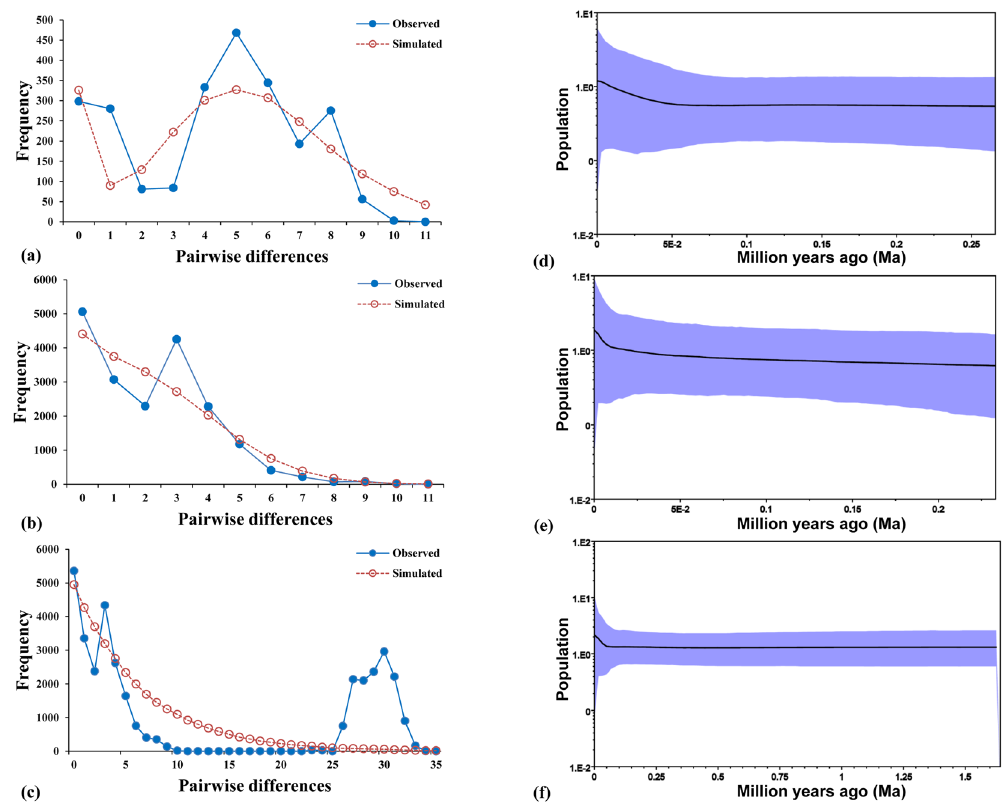
Figure 3. Mismatch distribution and Bayesian skyline plots (BSPs) for cytochrome b partial sequences of B . tibetanus sampled in the Qinling Mountains. The two approaches reveal obvious signals of demographic expansion for the Qinling lineages. The mean estimate and both 95% highest posterior density (HPD) limits are indicated. ( a , d ) The western lineage; ( b , e ) the eastern lineage; ( c , f ) the total samples (265